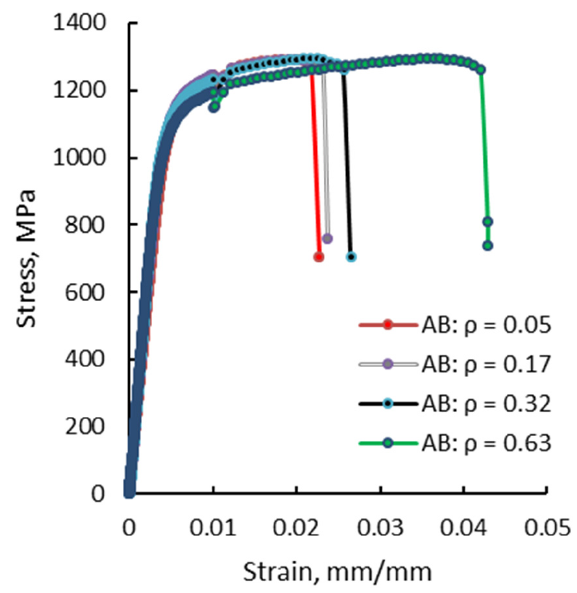
Figure 9. Stress-strain curves recorded for test pieces with different notch root radii tested in as-built condition.